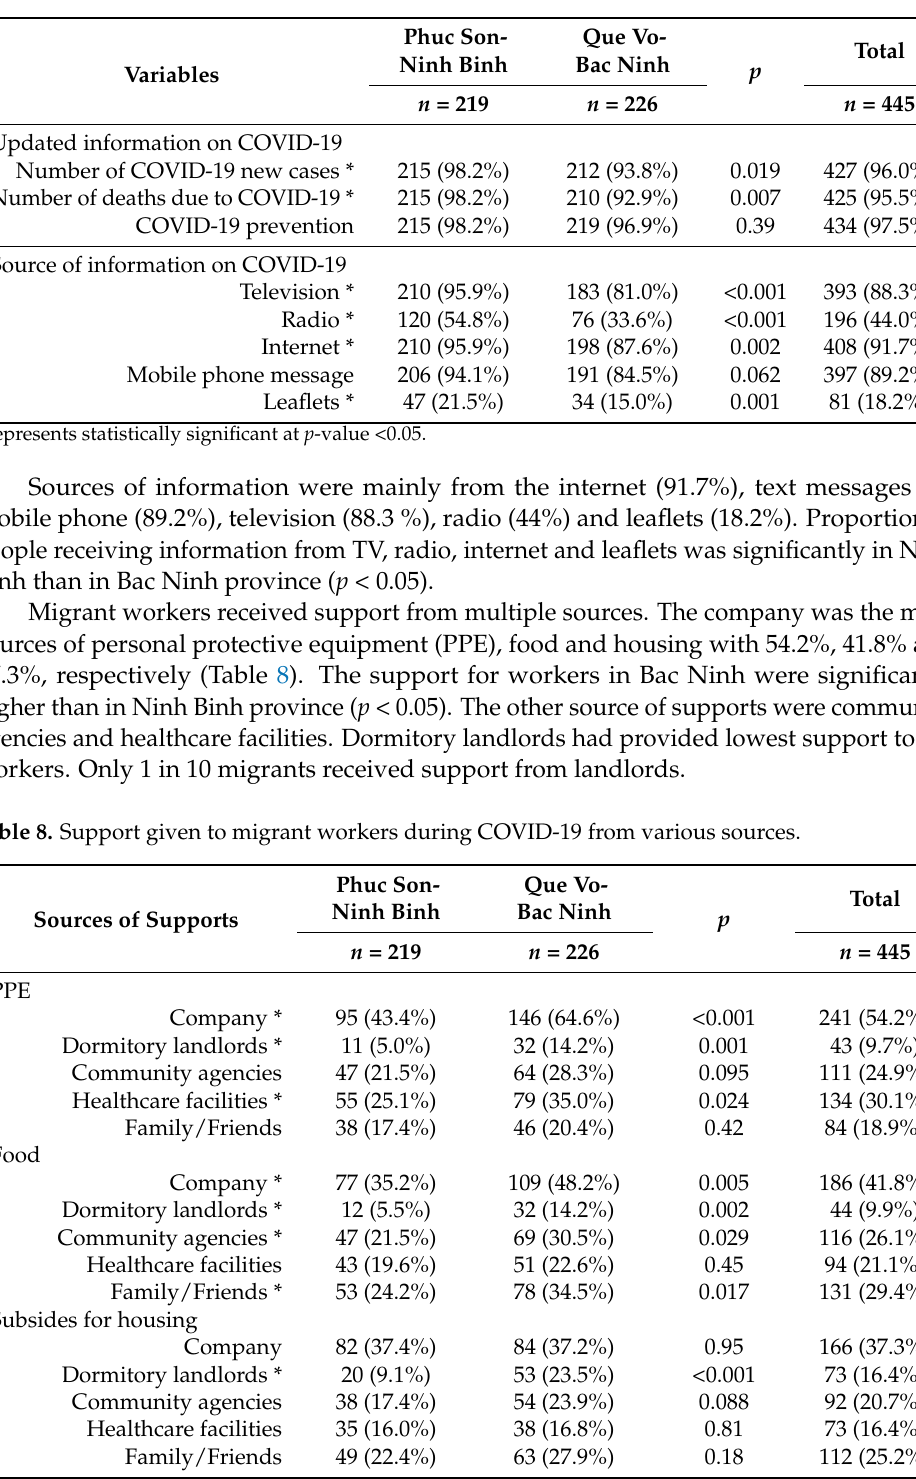
Table 7. Information received on COVID-19.